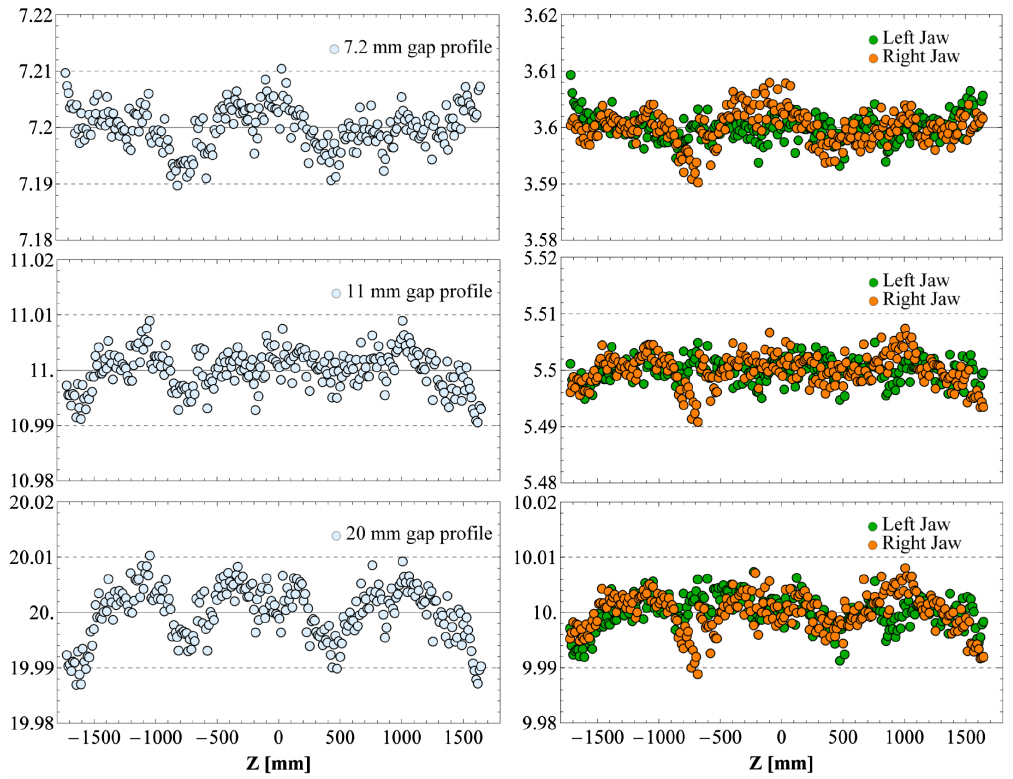
FIG. 16. Measured total gap in mm (left) and distance in mm between the gap center line and the pole tips on the left and right undulator jaws (right) vs z for several values of the gap. The horizontal dashed lines show that the mechanical tolerance of (cid:1) 10 μ m straightness has been met.